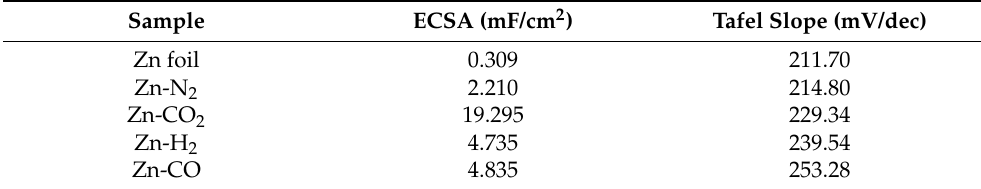
Table 2. The electrochemical active surface area (ECSA) and Tafel slope data of all